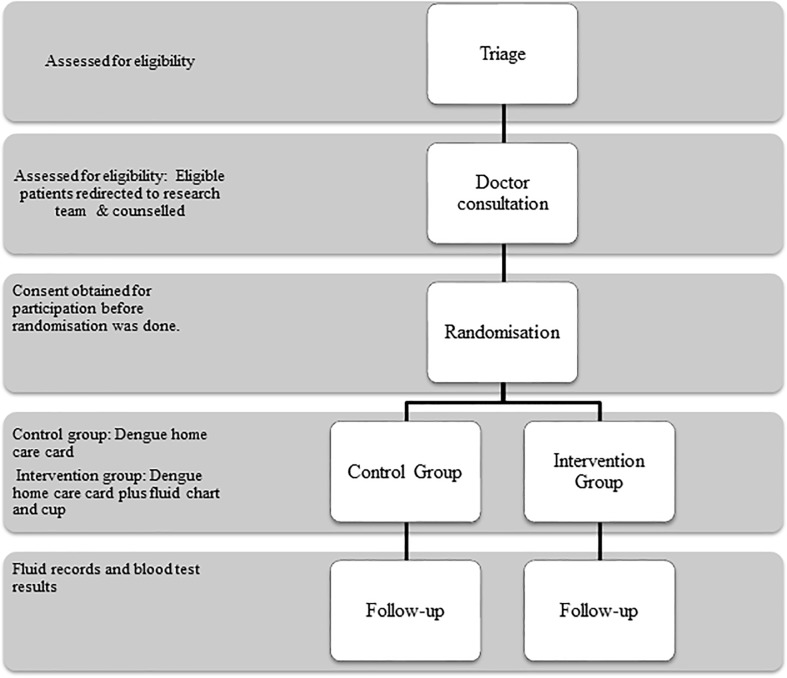
Flow of participants and trial process.